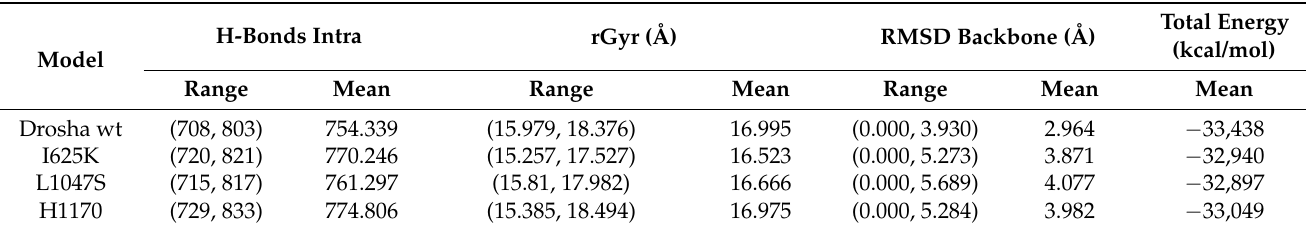
Table 2. Statistics of MD simulations. Intra-protein H-bonds, radius of gyration, RMSD values, total energy of the protein, and mean energy of clustered frames are